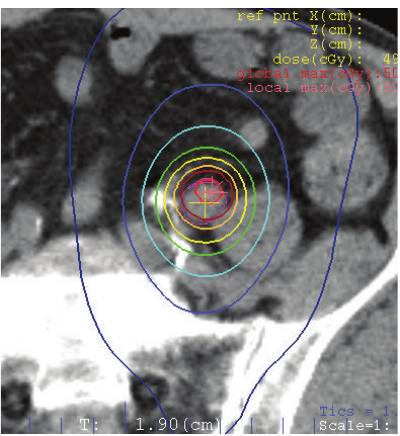
Figure 2: SBRT plan isodose line of case